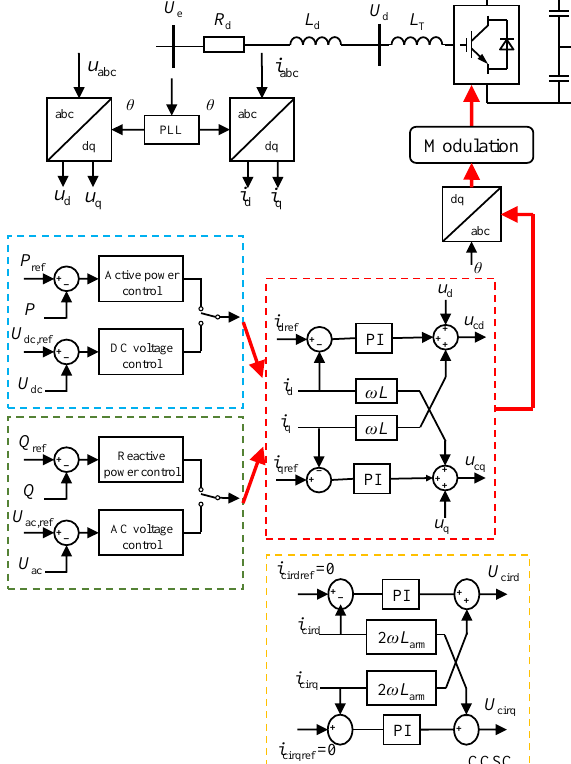
Figure 5. Structure diagram of an MMC control